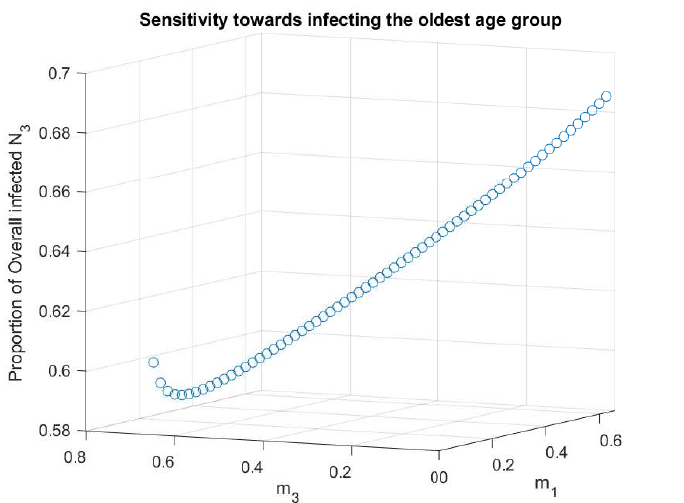
Figure 5. Change in overall infected of oldest age group based on the proportion of age